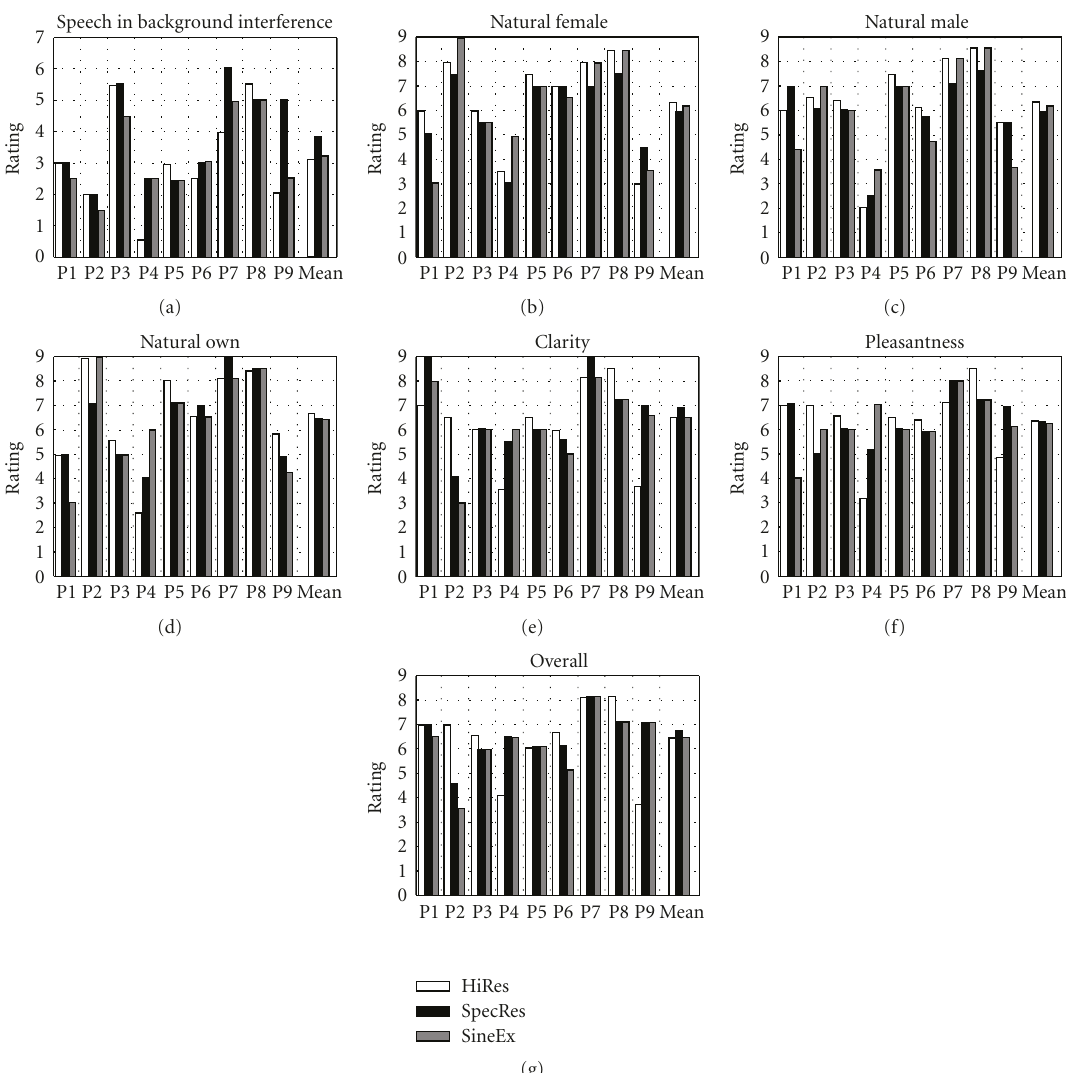
Figure 12: Results of the speech quality questionnaire using HiRes, SpecRes, and SineEx. Di ff erent items were rated on a 10-point scale. The cochlear implant subjects were asked to rate features of speech in di ff erent situations. The items are (a) speech in background interference, (b) natural female, (c) natural male, (d) natural own, (e) clarity, (f) pleasantness, and (g) overall speech quality. SineEx, the frequency selection, which is related to the channels to be stimulated, also incorporates a simple version of a perceptual model based on masking e ff